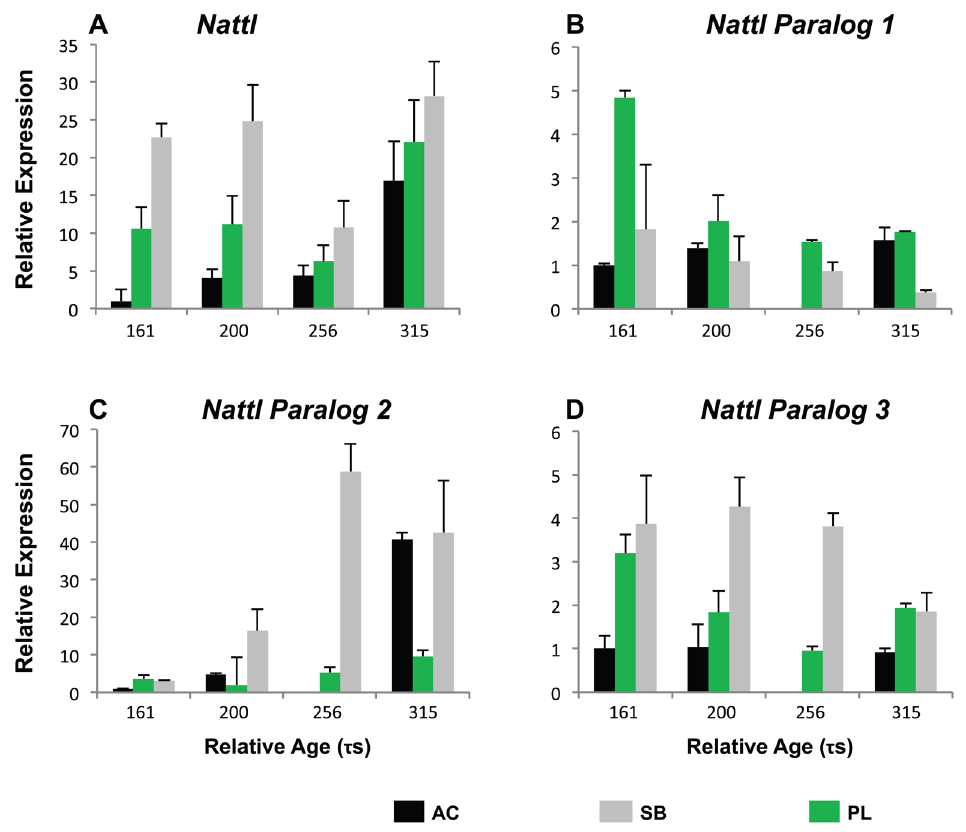
Figure 5. Relative expression of Natterin-like and its three paralogs during charr development in different morphs. The expression is graphed for different morphs (SB, AC and PL) at four developmental timepoints (161, 200, 256 & 315 τ s , relative to AC-charr at timepoint 161. A ) General nattl expression along charr development. B – D ) Expression of nattl paralogs 1–3. ANOVA showing the variation among morphs is summarized in S5